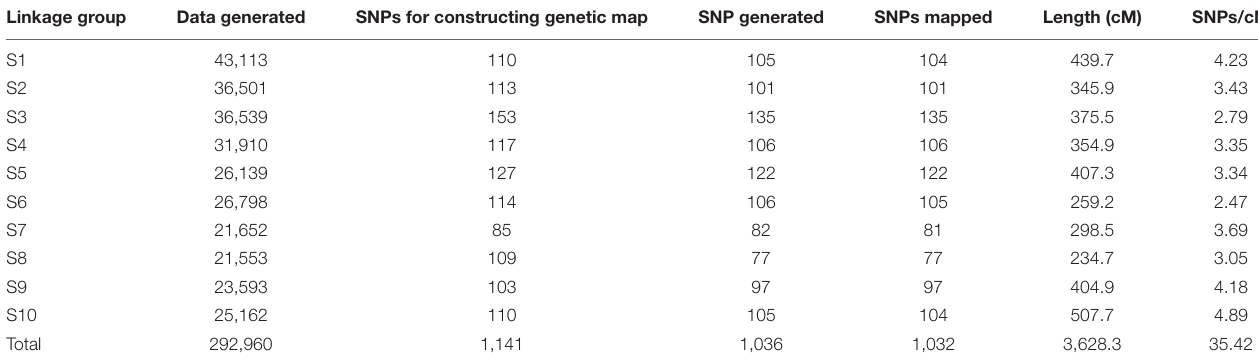
TABLE 4 | Marker coverage across the 10 linkage groups in sorghum for ICSV1 × ICSV700, F7 recombinant inbred line population. Linkage